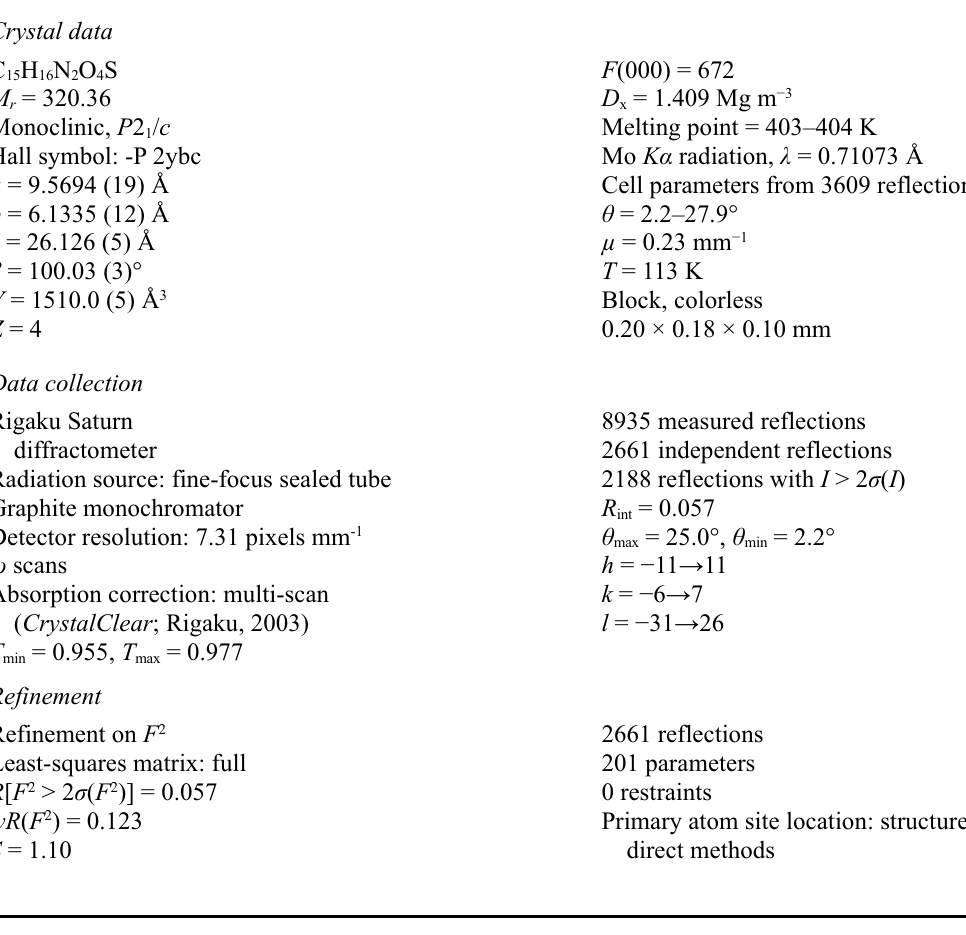
Figure 2 The crystal packing of (I) with hydrogen bonds drawn as dashed lines. N ,4-Dimethyl- N